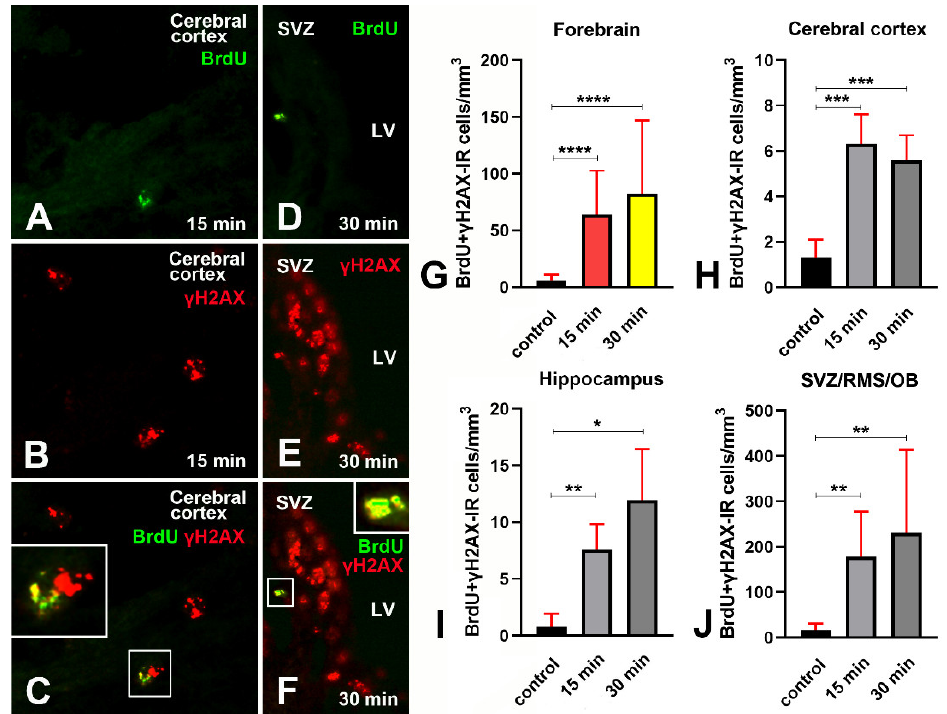
Figure 13. BrdU + γ H2AX double-labeling experiments in the forebrain of control and irradiated mice. ( A – F ) exemplificative images of the pattern of immunostaining in the cerebral cortex after 15 min survival ( A – C ) and SVZ after 30 min survival ( D – F ). Note the pattern of immunostaining in foci for both molecules. Two double-labeled cells (rectangles) are shown at higher magnification in the inserts. Abbreviations: LV = lateral ventricle; SVZ = subventricular zone of the lateral ventricle. Original magnifications: 20×, inserts, 40×. ( G – J ) Quantitative analysis of the volumetric density of double-labeled cells, in the whole forebrain, cerebral cortex, hippocampus, and SVZ/RMS/OB. Data are expressed as mean ± 95% CI. * 0.05 > p ≥ 0.01, ** 0.01 > p ≥ 0.001, *** 0.001 > p ≥ 0.0001, **** p < 0.0001. Bars are 95% CI. See Appendix J for numerical data of statistics.